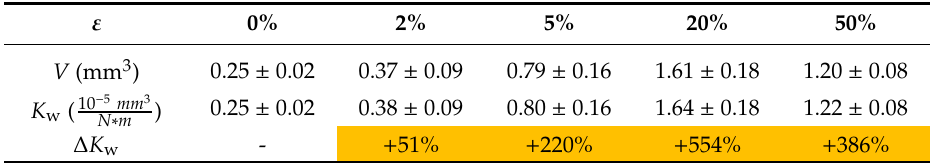
Table 1. Test results on the wear of deformed polymer (working with steel, tension, parallel direction, v = 0.33 m / s, and T 0 = 23 ◦